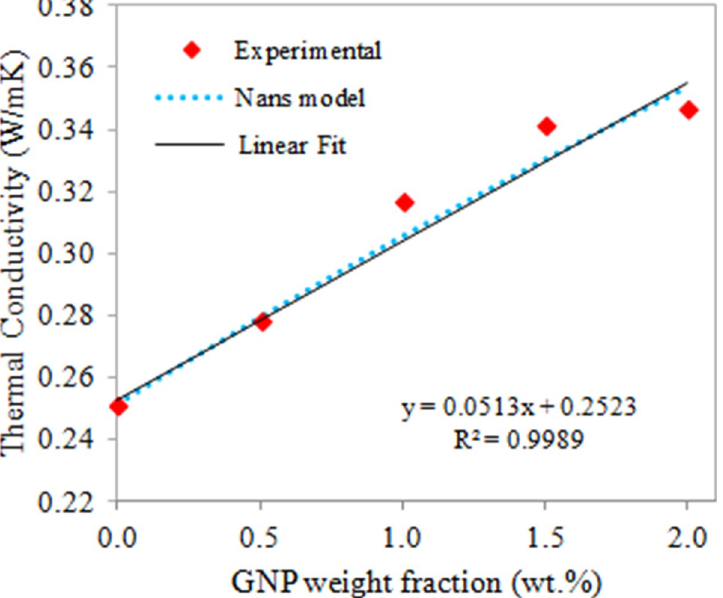
Fig 7. Thermal conductivity of the neat TPNR sample and TPNR/GNP with different nanofiller weight fractions.